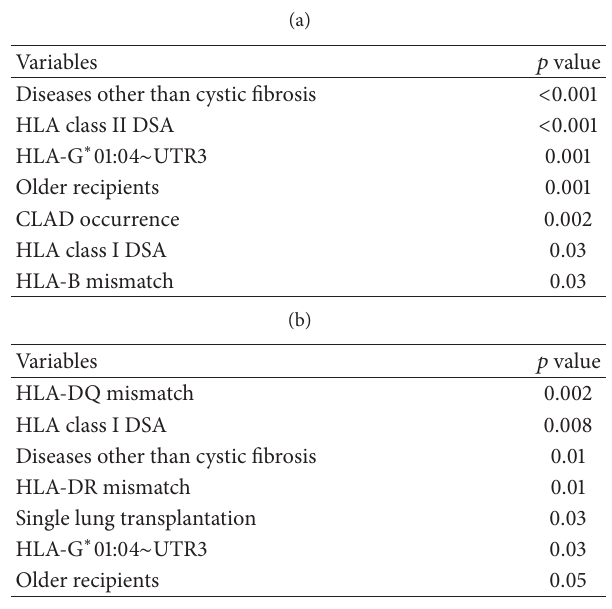
Table 1: (a) Univariate analysis of death risk factors. (b) Univariate analysis of CLAD occurrence risk factors.